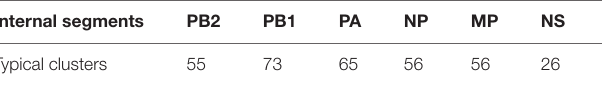
TABLE 2 | Numbers of typical clusters for six internal